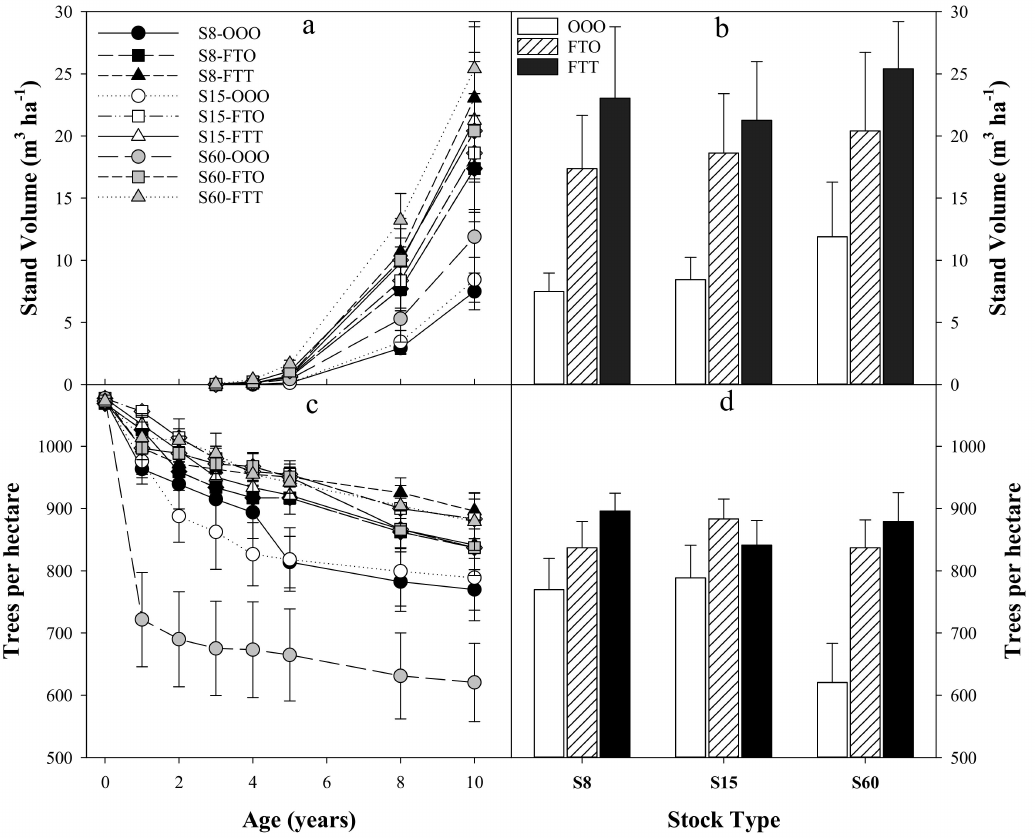
Figure 5. E ff ect of stock type and vegetation management regime on Douglas-fir: ( a ) mean stand volume over time, ( b ) stand volume in year 10, ( c ) mean trees per hectare over time, and ( d ) mean trees per hectare in year 10. Treatment descriptions are provided in Table 1 and treatment comparisons are provided in Table 3.